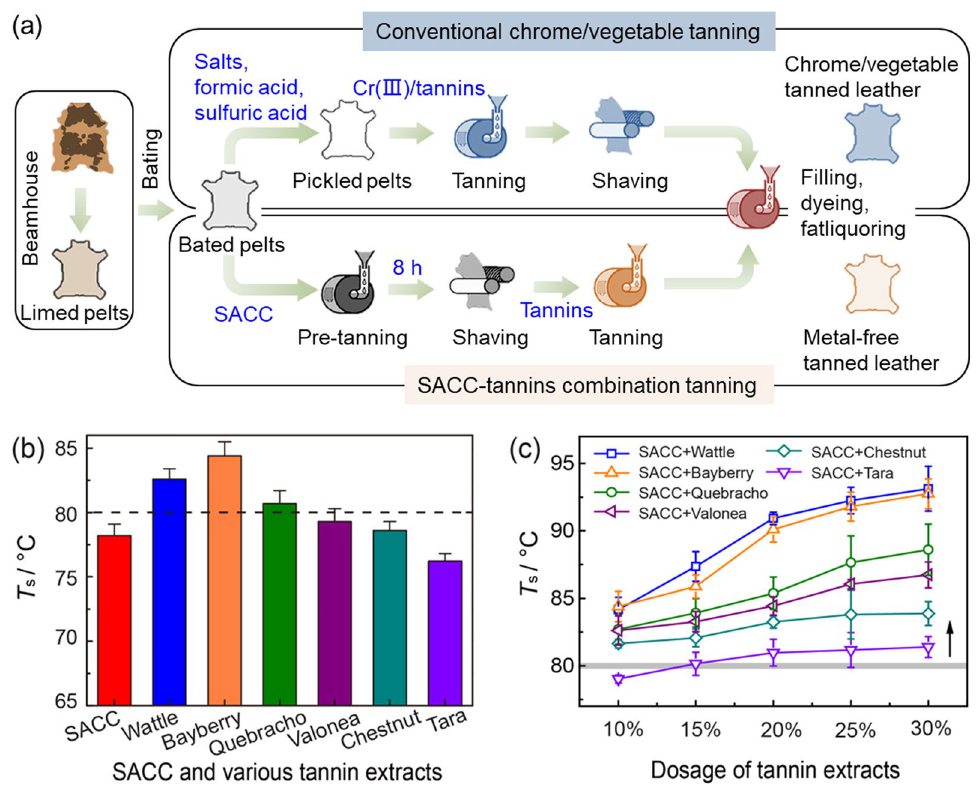
Fig. 1 a Route diagram of conventional chrome/vegetable tanning process and SACC-tannins combination tanning process. b T s of tanned leathers produced by SACC (10%) or various tannin extracts (25%) in solo tanning. c T s of tanned leathers produced by combination tanning systems (10% SACC various dose of tannin extracts). The error bars represent standard deviations (n +